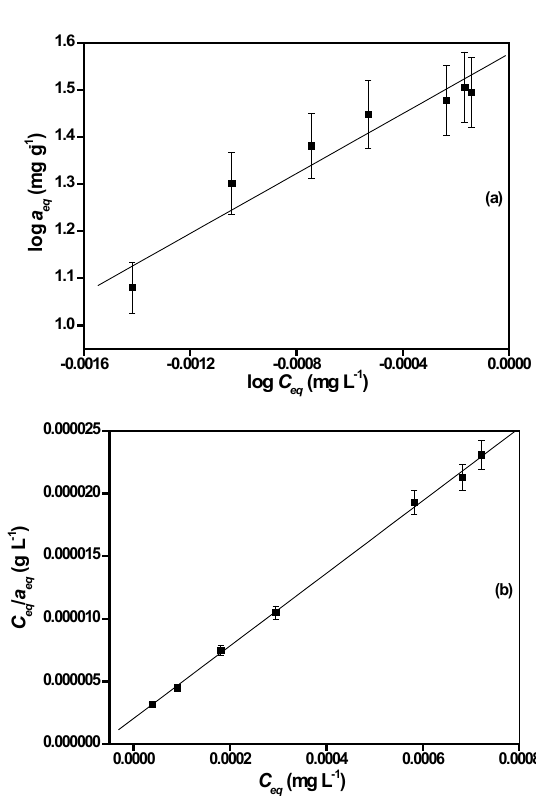
Figure 7. Isotherm of mercury(II) adsorption in Freundlich (a) and Langmuir (b) equations.